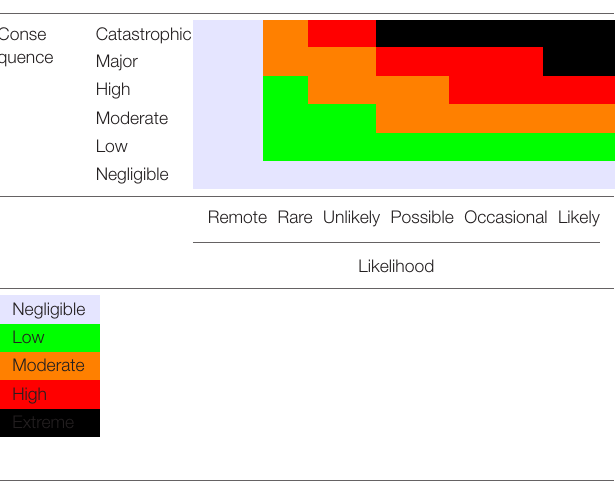
TABLE 6 | Confidence levels with descriptions [from Goodsir et al.